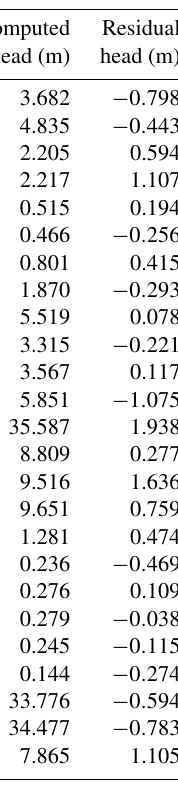
Table 1. Comparison between the observed and simulated hydraulic heads with related residuals, relative to the measurement campaign of February